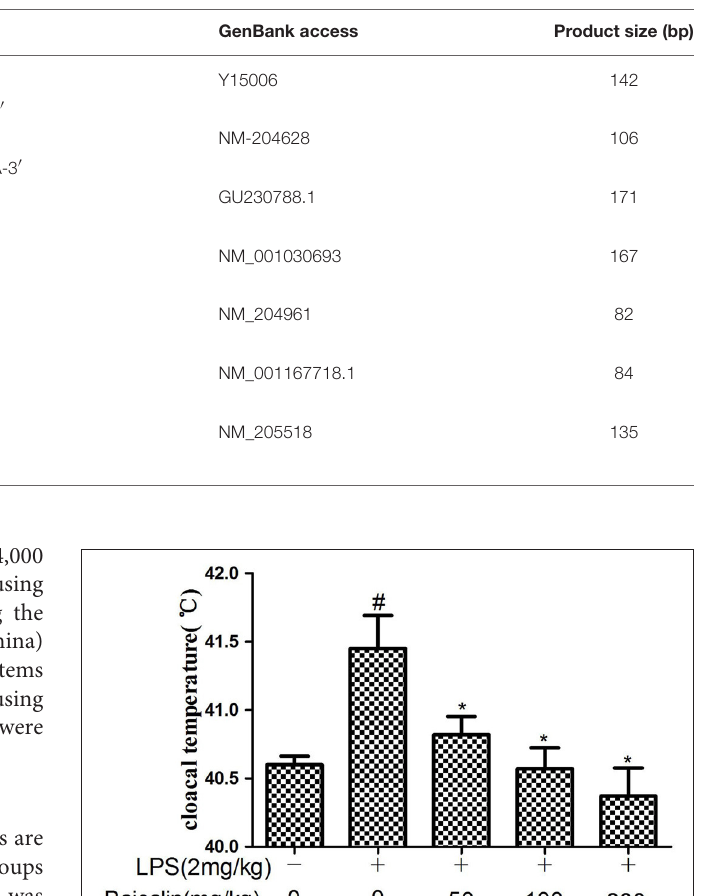
TABLE 1 | Primers used for the quantitative real-time PCR.